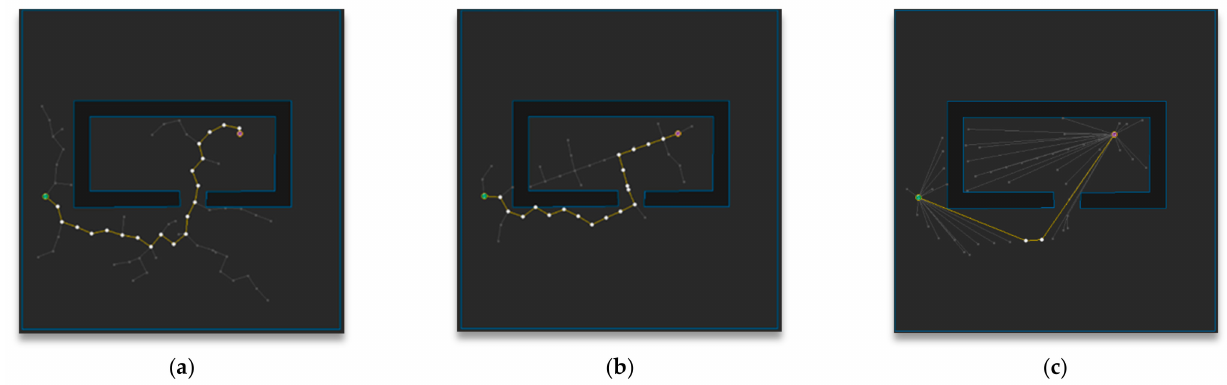
Figure 12. Experimental results of Map 2: ( a ) RRT; ( b ) RRT-Connect; ( c ) the proposed